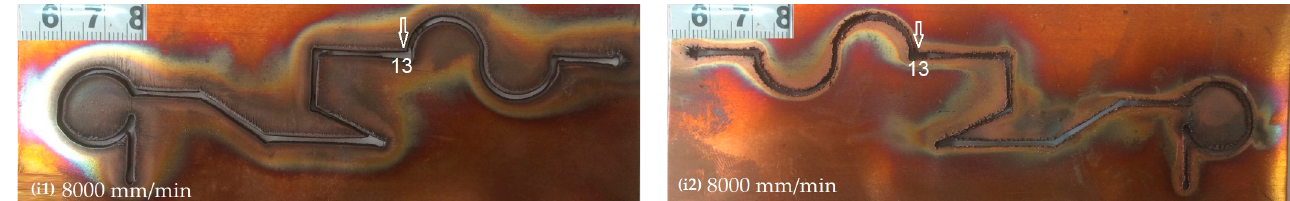
Figure 11. The cutting path width of ( i1 , i2 ) at 8000 mm/min at 30 A for Point 13. Points 14, 15, and 16 in Figure 2, which were located on the curved line on the cutting path, recorded the lowest readings of 1.403, 1.14, and 1.49 mm at 12,000 mm/min (Figure 9). However, as shown in Figure 6, the same points recorded higher readings at a lower 500 mm/min with values of 2.247, 1.659, and 2.43 mm, respectively. Most of the readings at these points for all points indicated that the lowest cut width accompanied the highest cut feed rates. The readings of the cutting width were lower than average with lower cut feed rates, which provided a good cut